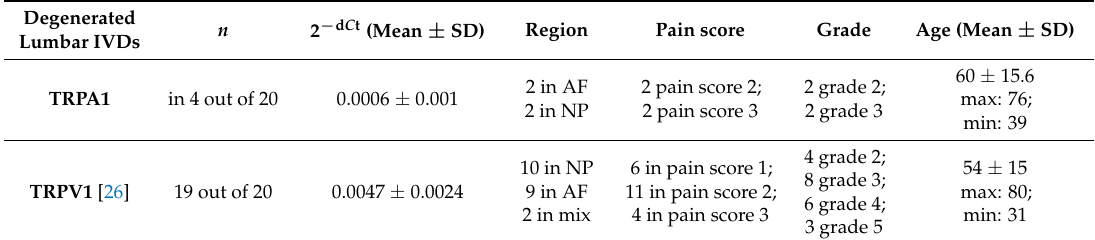
Table 1. Gene expression of TRPA1 and TRPV1 in human intervertebral disc (IVD) tissue. Some donor tissues were divided into nucleus pulposus (NP) and annulus fibrosus (AF), resulting in more AF and NP samples ( n = 21 in region, pain score, grade) than a total number of donors ( n = 20). Degenerated Lumbar IVDs